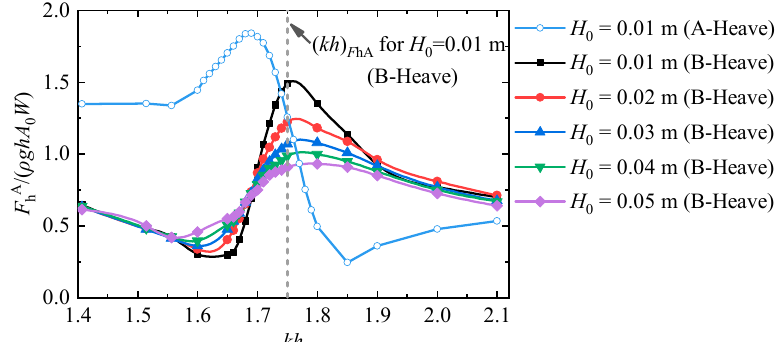
Figure 4. Variations of the normalized horizontal wave force on Box A for the B-Heave structure systems. The results for the A-Heave structure system with H 0 = 0.01 m is also shown here for com- parison.